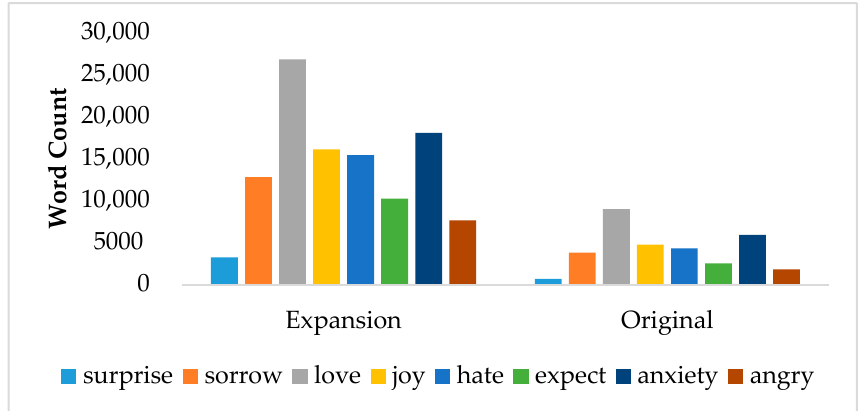
Figure 2. Comparison of the Lexicon Scale of Expansion and the Original.